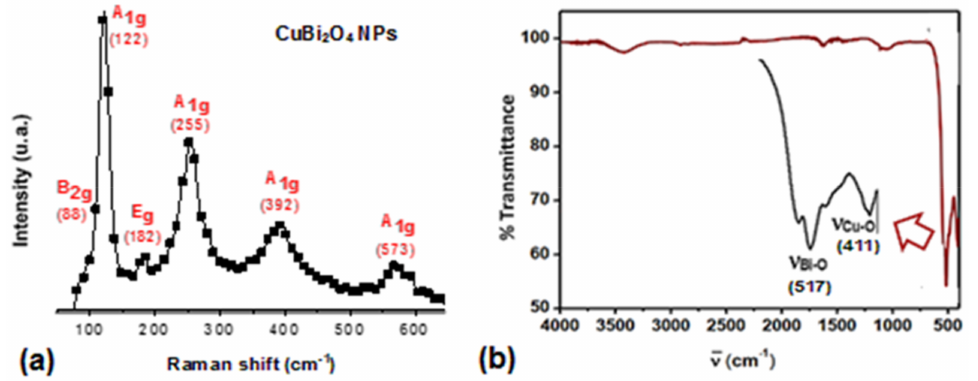
Figure 3. Spectra of ( a ) Raman and ( b ) FTIR of the CuBi 2 O 4